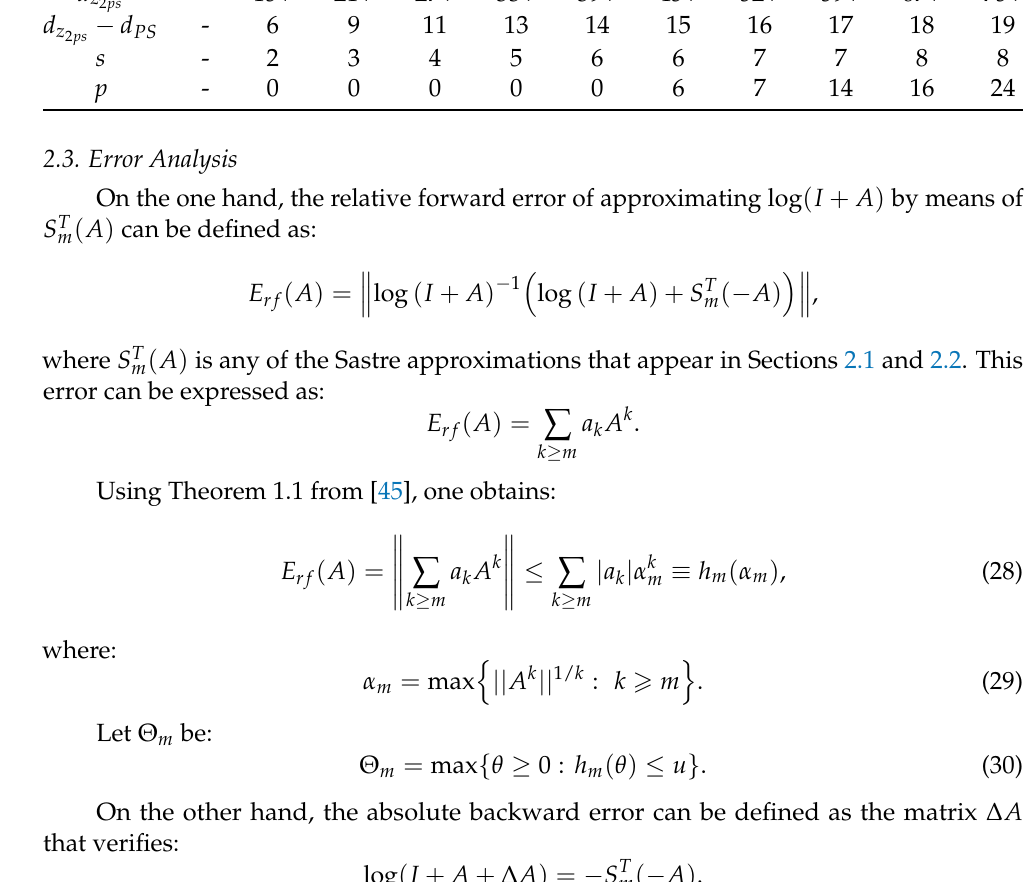
( A ) from (27), ( 6 s + 3 + p )+ ( A ) in each